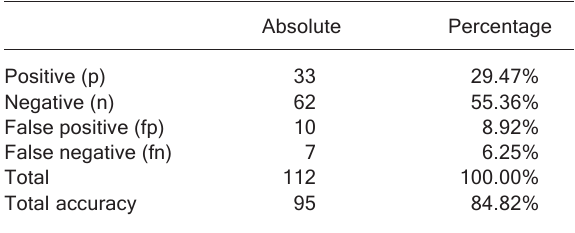
Table 1. Results of isolated respiratory cycle